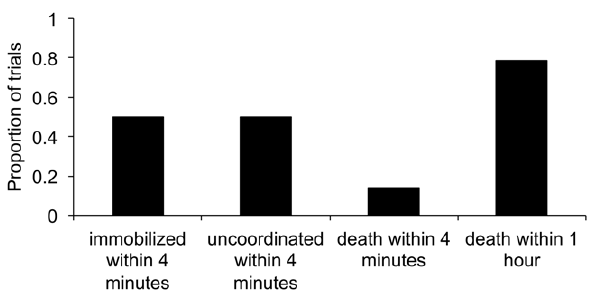
Figure 4. Effect of chemical secretion on L.humile . Proportion of L. humile workers that demonstrated specific behaviors after contact with the P. imparis secretion. There were N =14 trials in which the P. imparis ant secreted on the L. humile